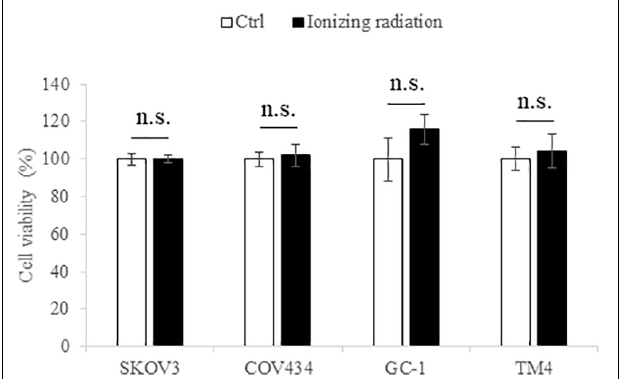
FIGURE 1 | The ionizing radiation exposure (10 cGy) has no effect on the cell viability of SKOV3, COV434, GC-1, and TM4 cells. The white bar represented the control group; the black bar represented the ionizing radiation group. N.s., not statistically significant.